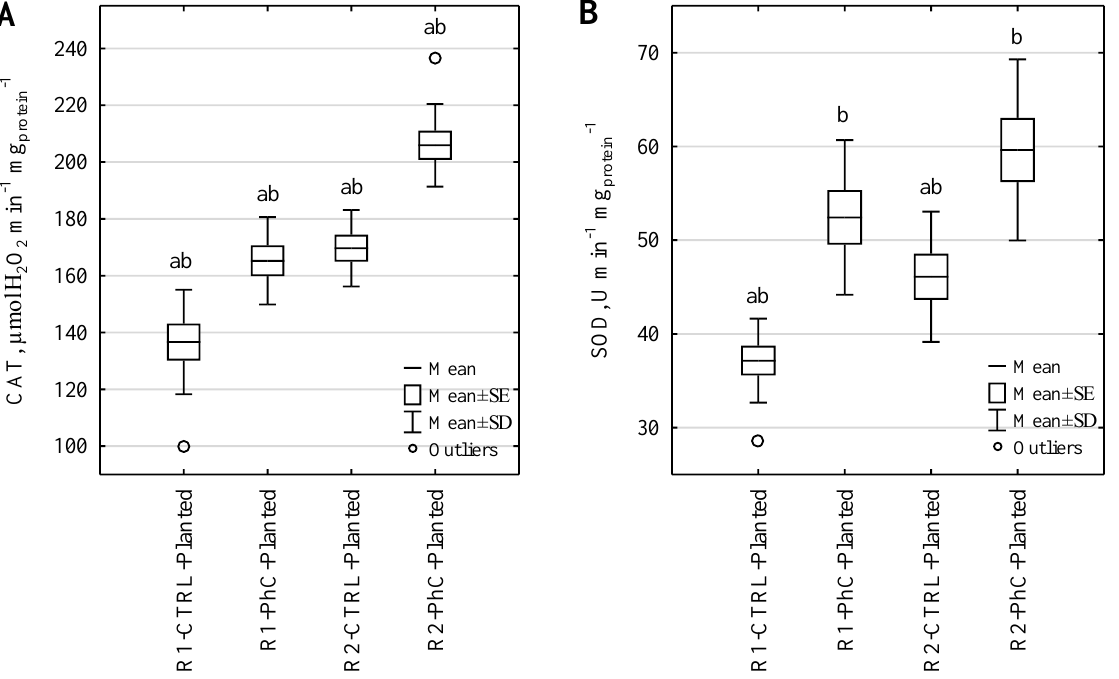
Figure 3. Activity of CAT ( A ) and SOD ( B ) in M. giganteus . (a) Statistically significant differences between counterpart types of columns (CTRL or PhC) with different frequency of wastewater dosing (Student ’ s t -test, α = 0 .05); (b) statistically significant differences between control wastewater and wastewater containing pharmaceuticals (Student ’ s t -test, α = 0 .05).